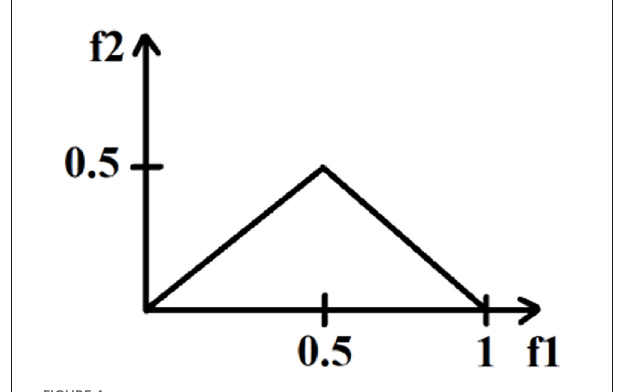
FIGURE4 The non-redundant region of bispectrum